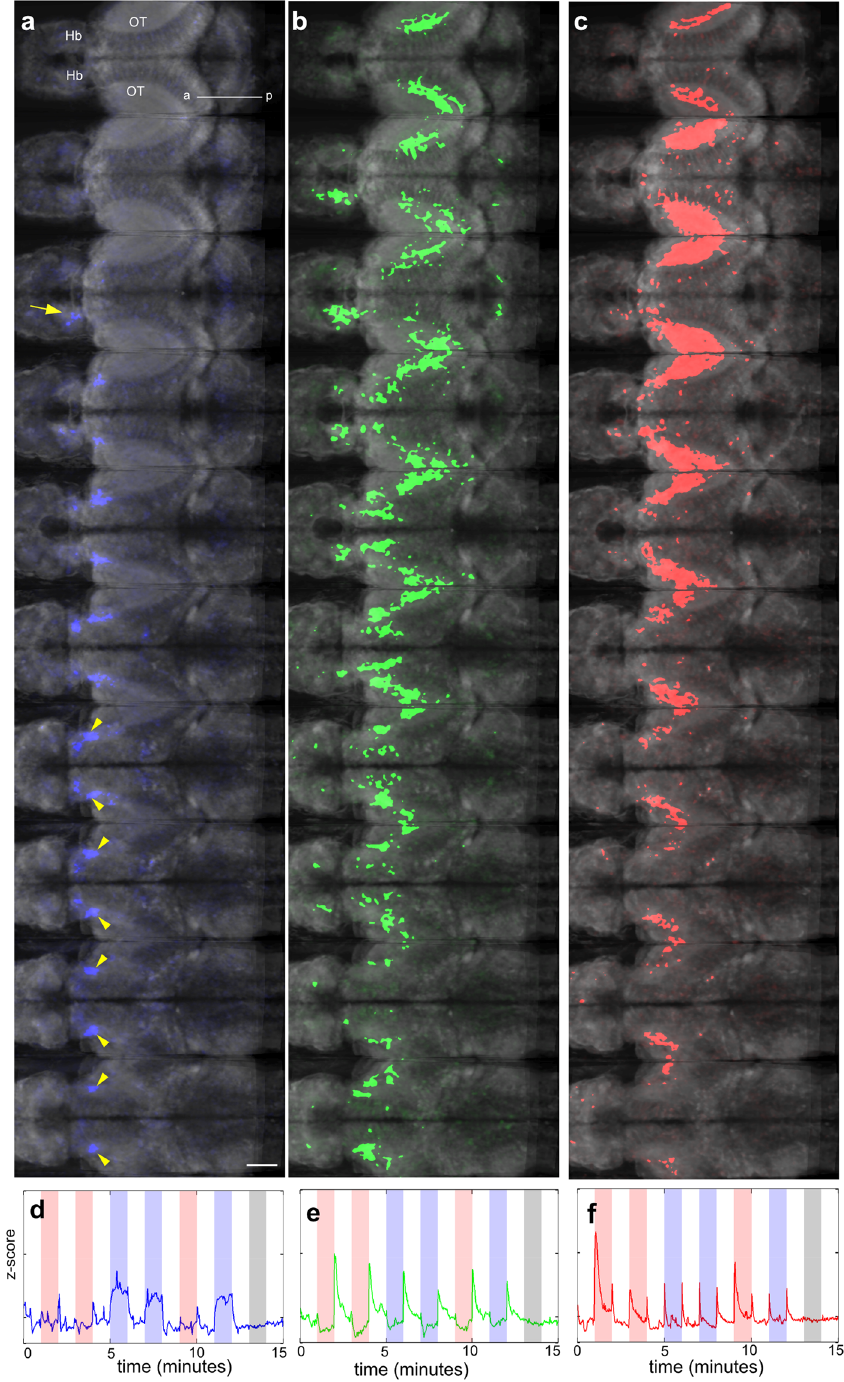
Figure 6. Averaged response of the brain to irradiance change. ( a–c ) Regions with sustained response to blue light ( a ), to offset of light ( b ) and to onset and offset of both blue and red light ( c ). The corresponding activity traces are shown in panels (d,e and f). These data are compiled from 7